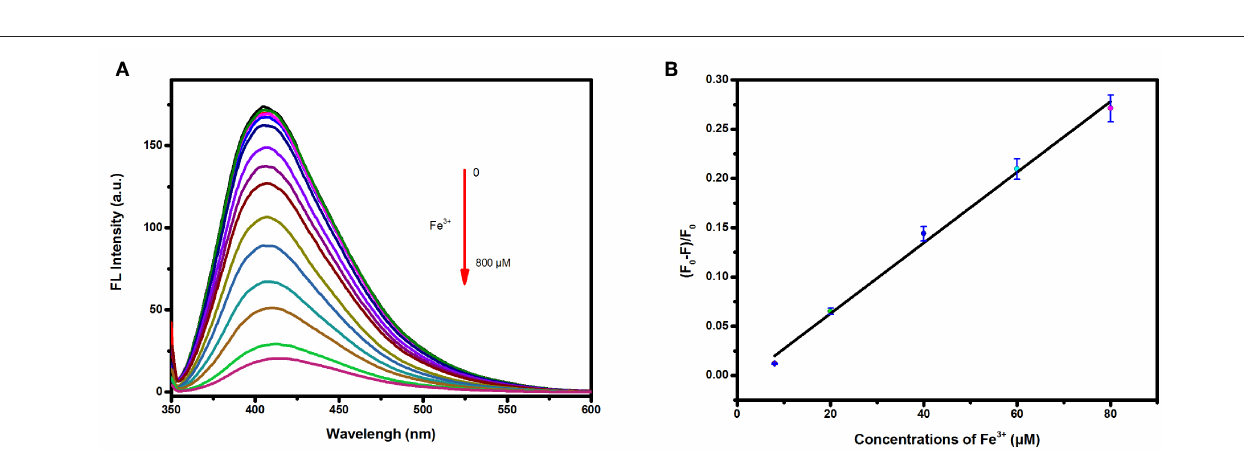
FIGURE 4 | (A) Fluorescence response of the carbon dots in presence of tap water containing different concentrations of Fe 3 + (from top to bottom: 0, 2, 4, 6, 8, 20, 40, 60, 80, 150, 200, 300, 400, 600, and 800 µ M); (B) Corresponding relationship between (F 0 -F)/F 0 and the concentrations of Fe 3 + of tap